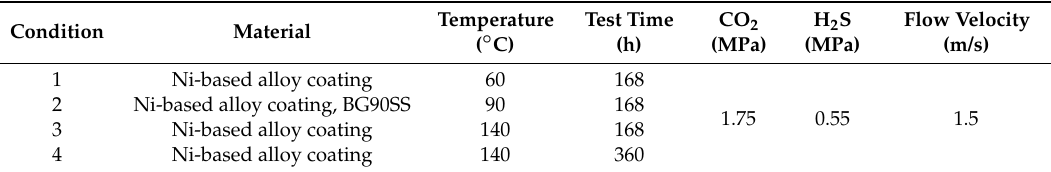
Table 3. Conditions of the weight loss